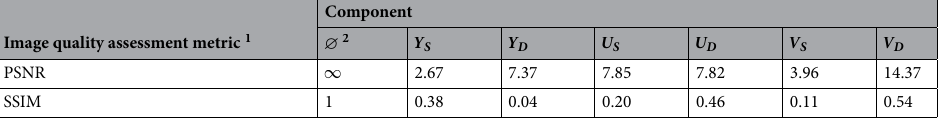
Table 8. The quality of the reconstructed image when Gaussian noise is added to a component. The experimental results are obtained on the DRIVE dataset. u = 0 , σ = 0.01 . the reconstructed image and the original image.